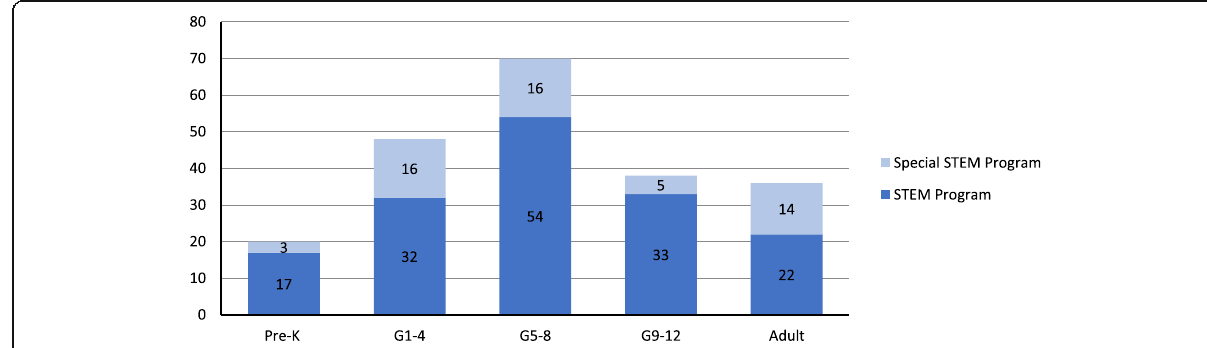
Fig. 12 The number of projects in STEM education for different groups of participants (Note: Pre-K: preschool-kindergarten; G1 – 4: grades 1 – 4; G5 – 8: grades 5 – 8; G9 – 12: grades 9 – 12; adult: post-secondary students and